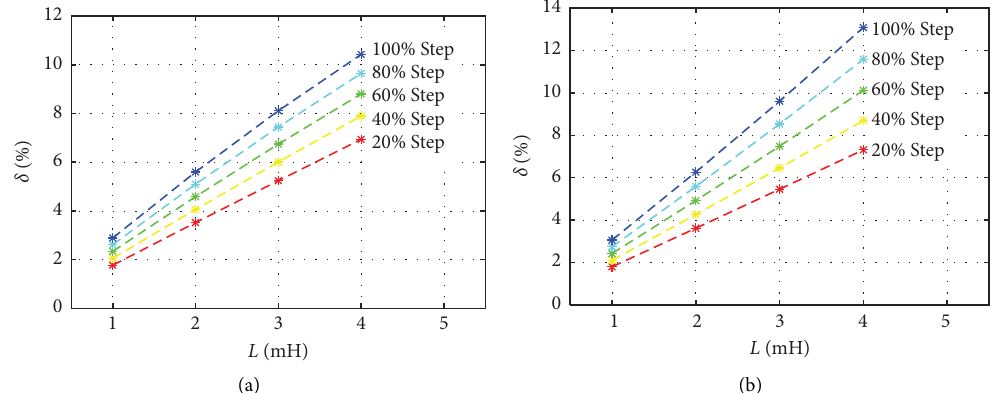
Figure 6: Te simplifcation error δ under diferent inductance and load current step change at V positive step change ( θ 0 � π /3) and (b) positive step-change ( θ 0 � 2 π /3 ° ).